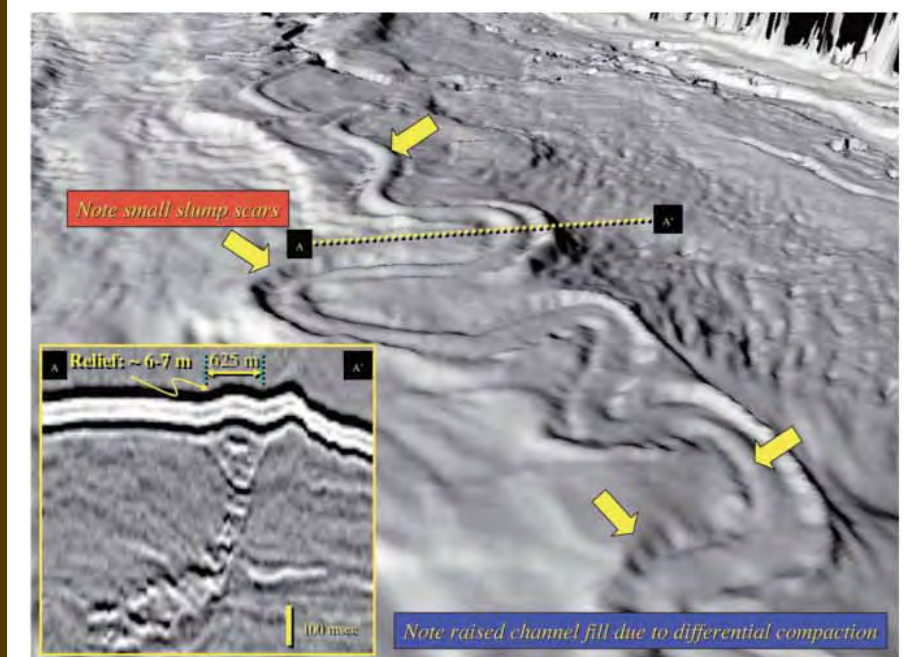
Figure 2. Illuminated and perspective views of the surface acquired by 3-D seismic imaging. The elevated aspect of the channel thalweg with its associated levees becomes quite apparent. The inset depicts a cross-section through the channel showing that the thalweg is associated with high re fl ection amplitude, indicative of a higher acoustic impedance relative to the surrounding mud and therefore suggesting the presence of sand. After Posamentier (2003) and Posamentier